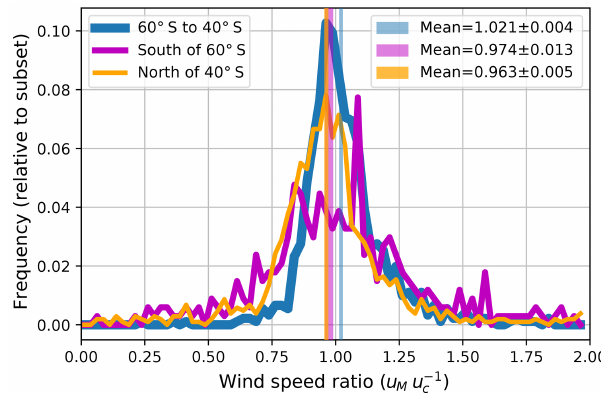
Figure 12. Histogram of the wind speed ratios for u M predicted by ERA-5 over u c estimated from the flow distortion-corrected wind speed. The dataset has been split for ship locations north of 40 ◦ S, between 40 and 60 ◦ S, and south of 60 ◦